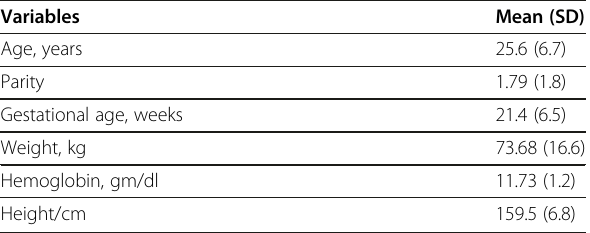
Table 1 Basic characteristics of the pregnant women included in the study at Khartoum Teaching Hospital, Sudan